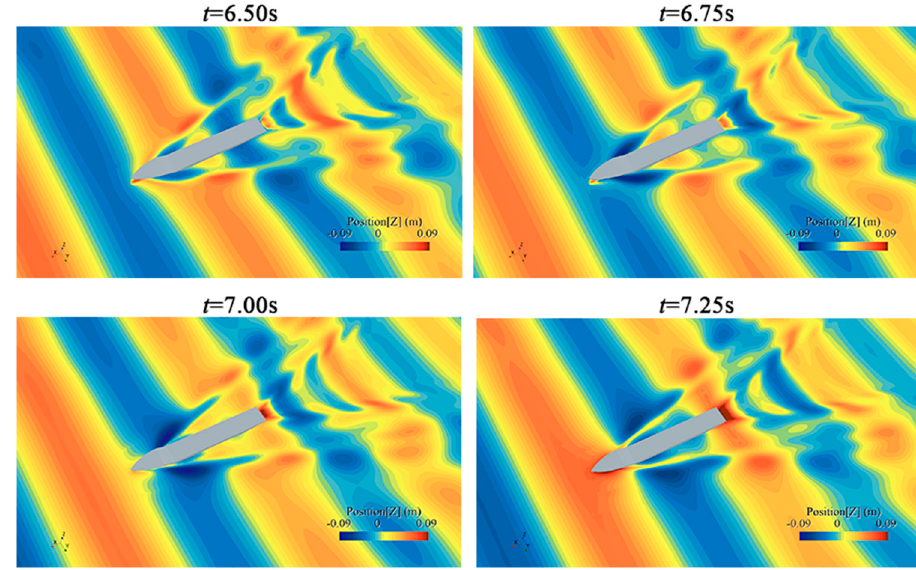
Figure 13. The wave pattern at typical time in regular waves.